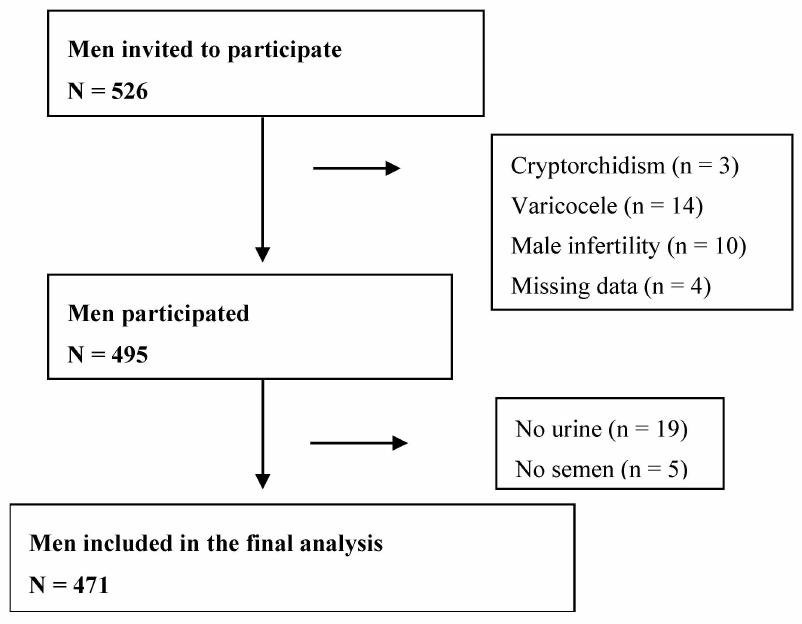
Figure 1. The inclusion and exclusion of participants in the